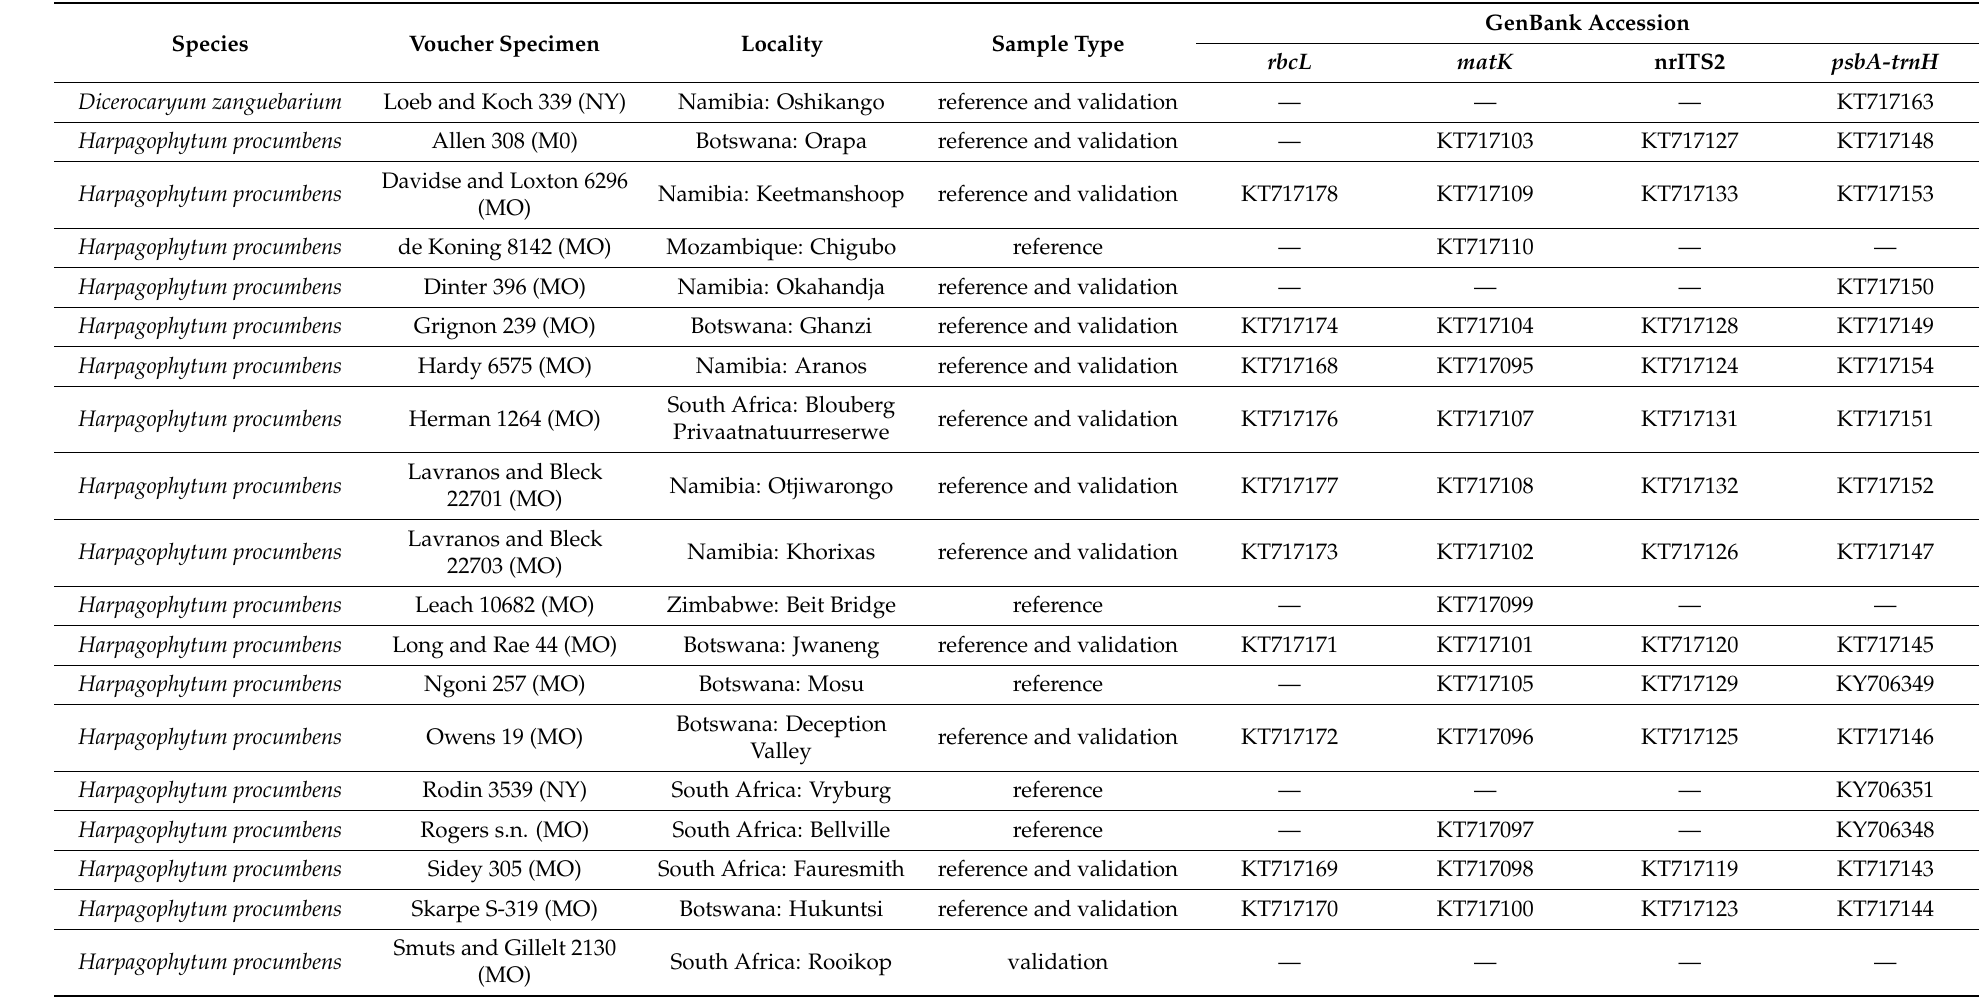
Table 1. Morphologically identifiable reference samples used to generate rbcL , matK , nrITS2, psbA-trnH and/or psbA-trnH mini-barcode sequences and to validate the psbA-trnH mini-barcode. Standard herbarium codes are used [41]. Cultivated specimens are indicated, all others are presumed to be wild collected. All sequences except EU531713 [42] were produced for this